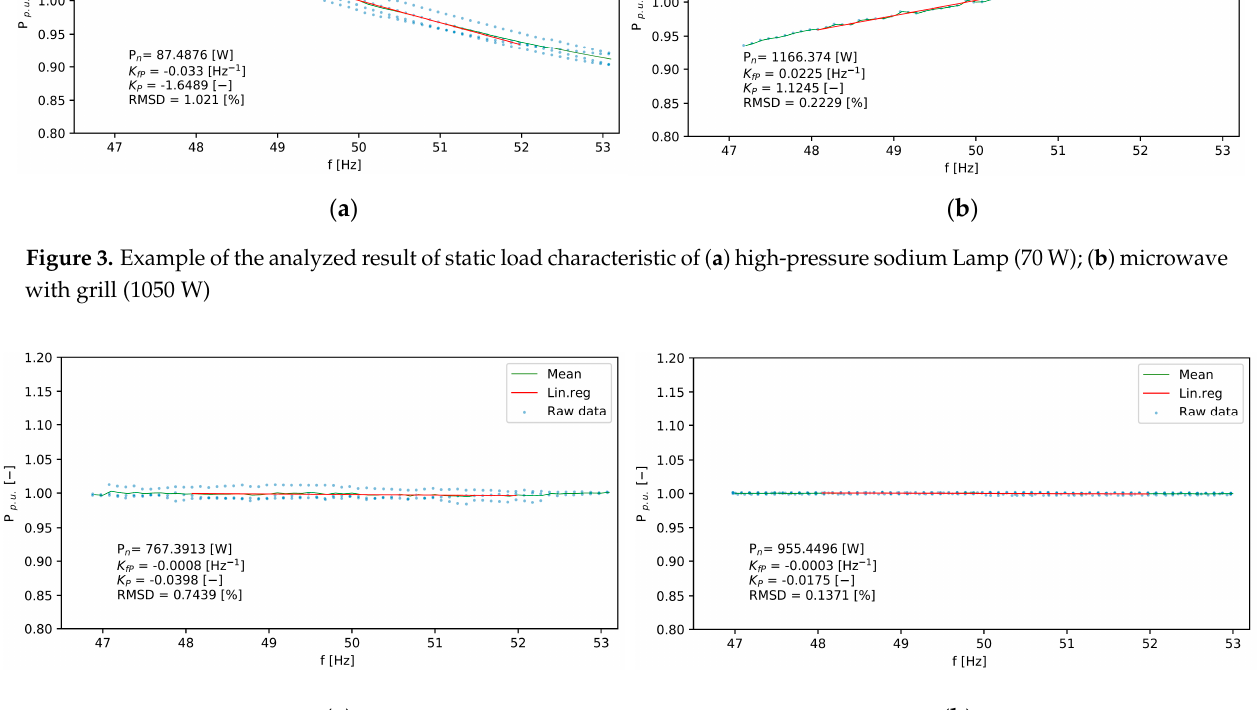
Figure 5. Example of the analyzed characteristics of Wi-Fi router ( a ) K P , K fP ; ( b ) K Q , K fQ . ( a ) ( b ) Figure 6. Example of the analyzed characteristics of Wi-Fi router. ( a ) K fTHDi , K THDi ; ( b ) K fPF , K PF . 3. Measurement Results Tables 4 and 5 show the results of chosen parameters related to analyses of static frequency characteristics. Furthermore, they compare them by general categorization. Re- sults in Table 4 refer to the evaluation of K P and K THDi , while results in Table 5 show K Q and K PF results. In all cases, the nominal (50 Hz) value of the quantity is stated along with RMSD. Based on the results, analyzed home appliances can be sorted according to the size of the frequency sensitivity coefficient value (Table 4): •